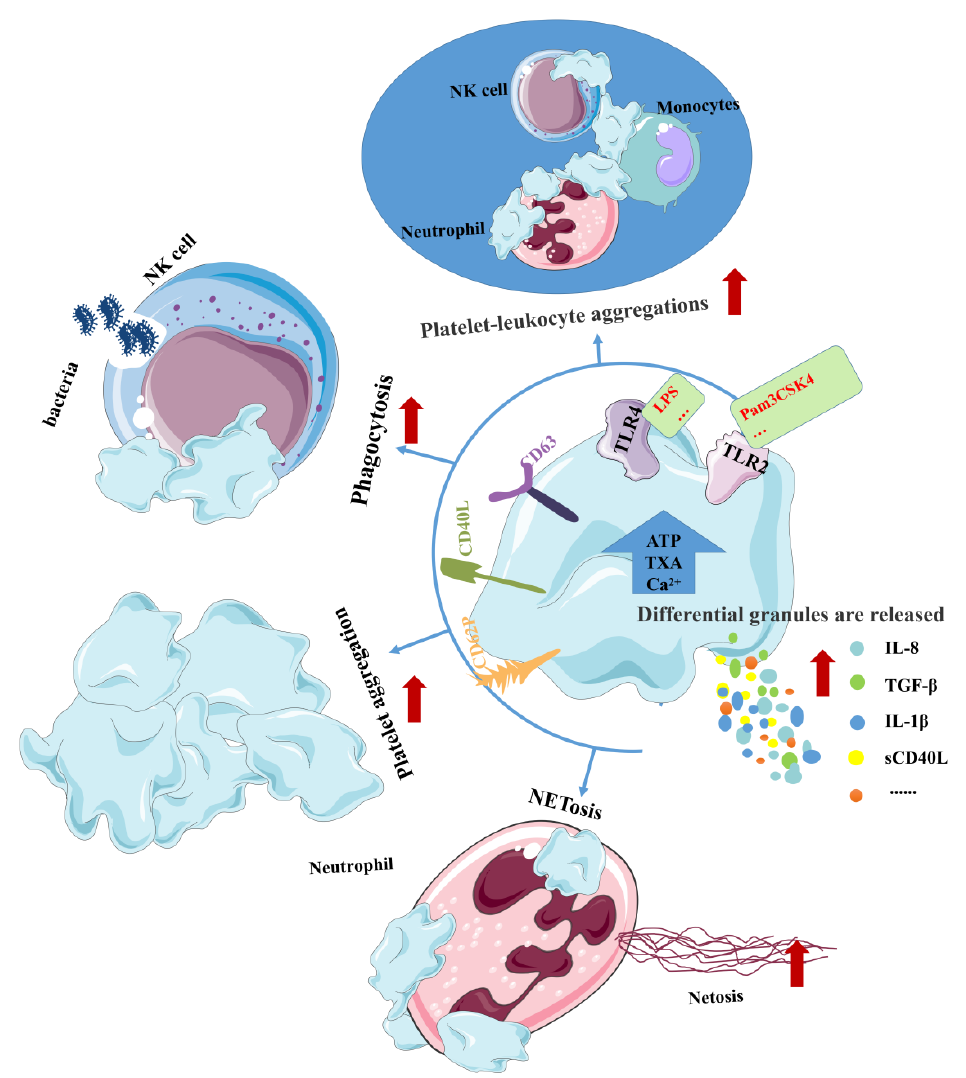
Figure 6. TLR2 and TLR4 increase platelet function. The activation of TLR on platelets can release a large number of inflammatory factors, activate and aggregate platelets, and recruit other cells to aggregate or carry out anti-inflammatory, antibacterial and other effects. Red arrows indicate the enhanced physiological effects. NK cell: natural killer Cell; LPS: Lipopolysaccharides; ATP: adenosine triphosphate; TXA: Tranexamic Acid; TGF- β : Transforming Growth Factor Beta; sCD40 L: soluble CD40-ligand; NETosis: neutrophil extracellular trap (NET)